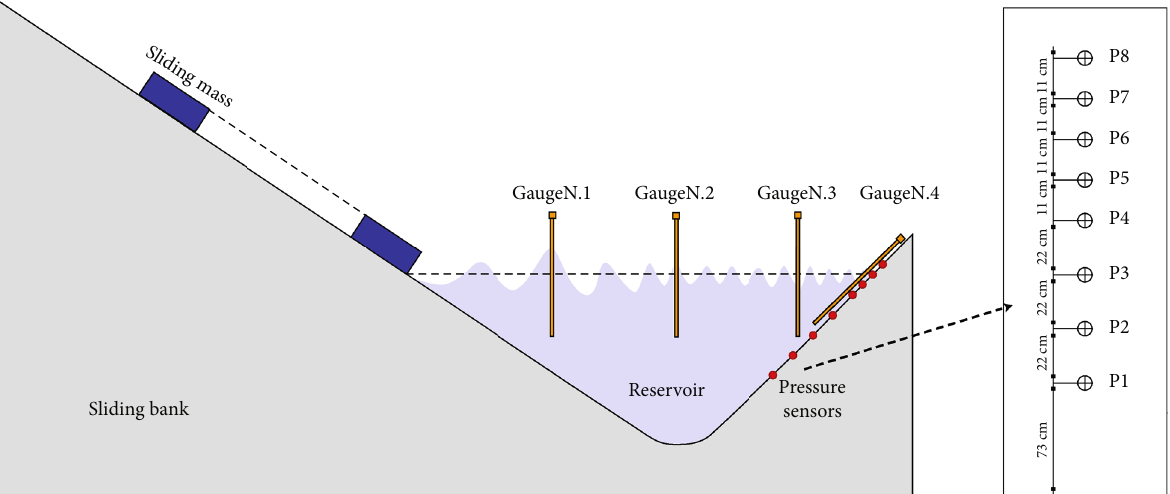
Figure 1: Schematic diagram of the physical model.